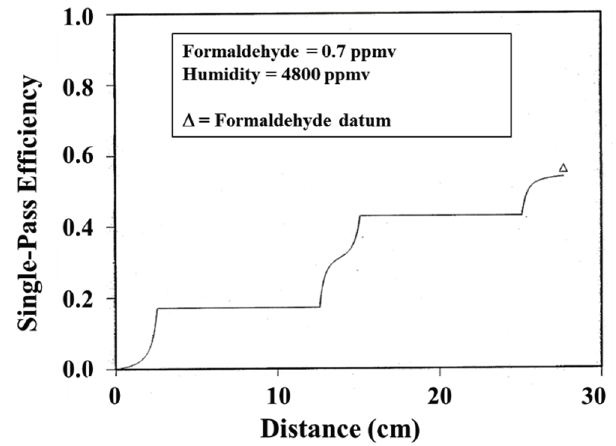
Figure 7. Photocatalytic reactor design flow diagram.